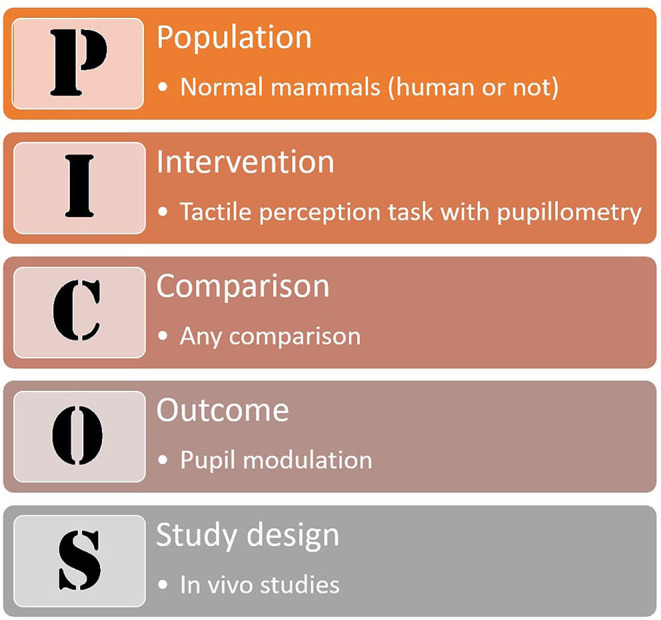
The PICOS strategy.